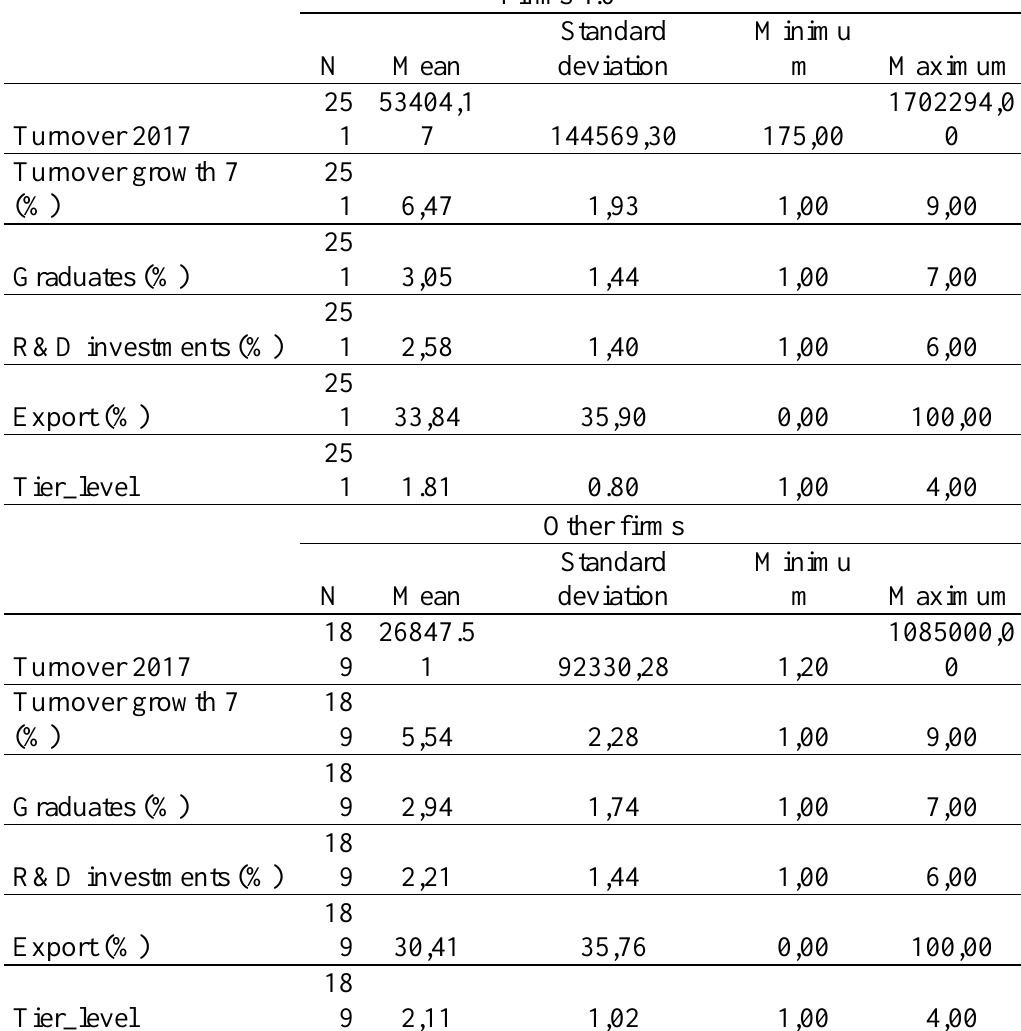
Table 4: Comparison between the descriptive statistic of Firms 4.0 and those firms of the automotive industry without Industry 4.0 plans.